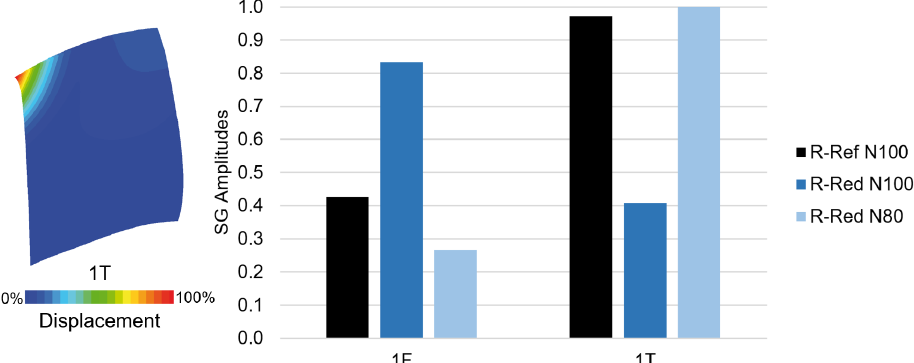
Figure 8. Normalized SG Amplitudes during Stall